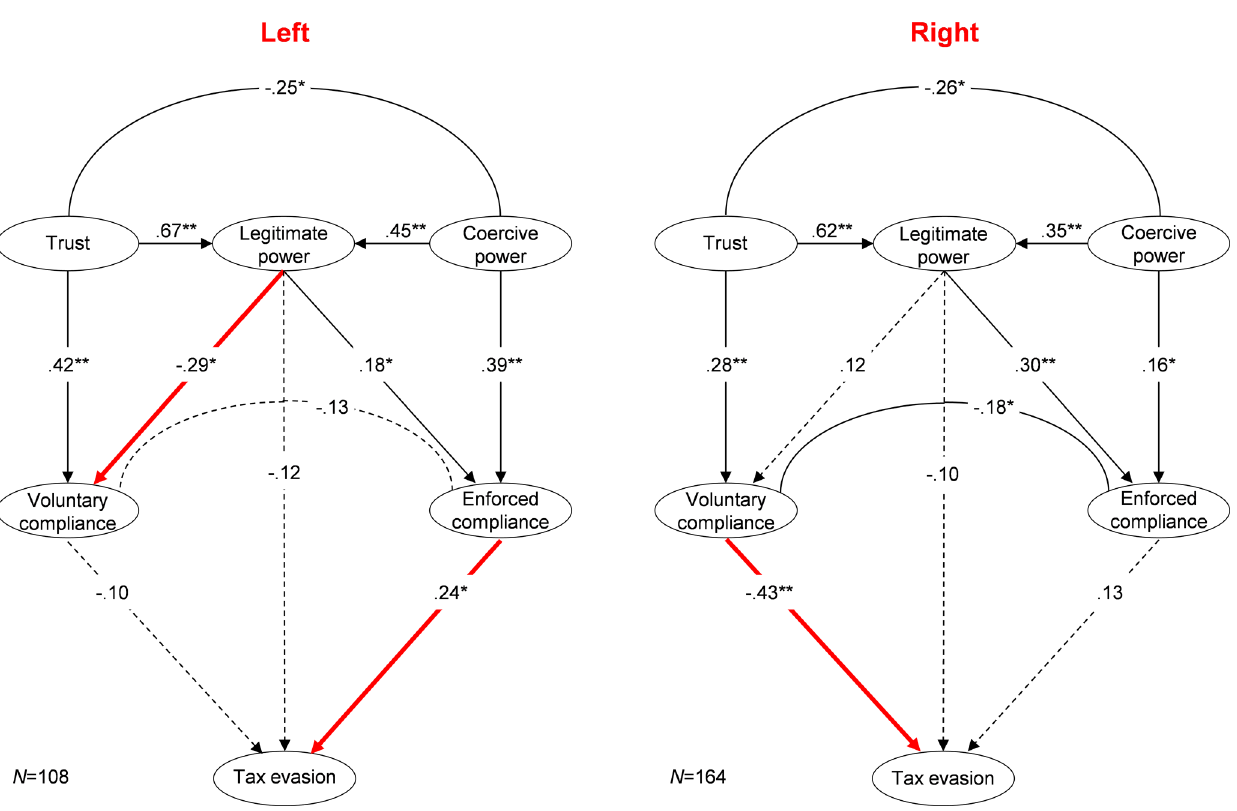
Figure 2. Structural equation models for subsamples by political ideology (only latent variables are displayed) Note . Numbers represent standardized path coefficients (and correlations, in the case of the relation between trust and coercive